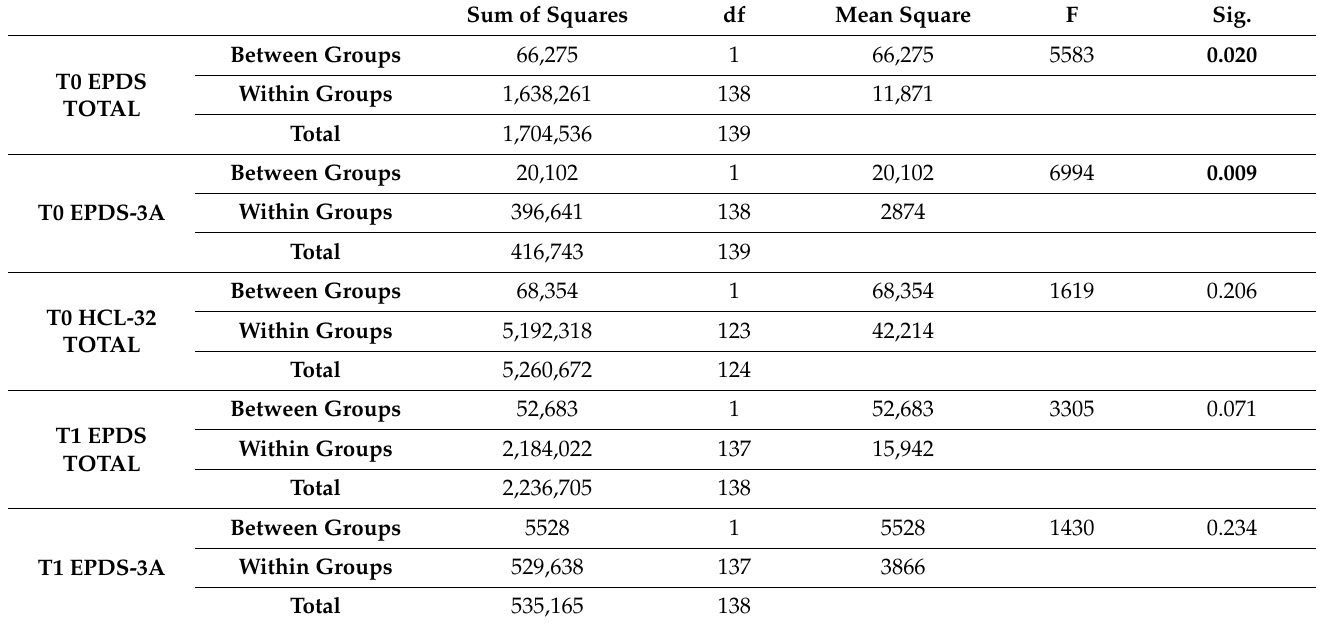
Table 3. ANOVA one-way for EPDS, HCL-32, by COVID and Non-COVID samples. Sum of Squares df Mean Square F